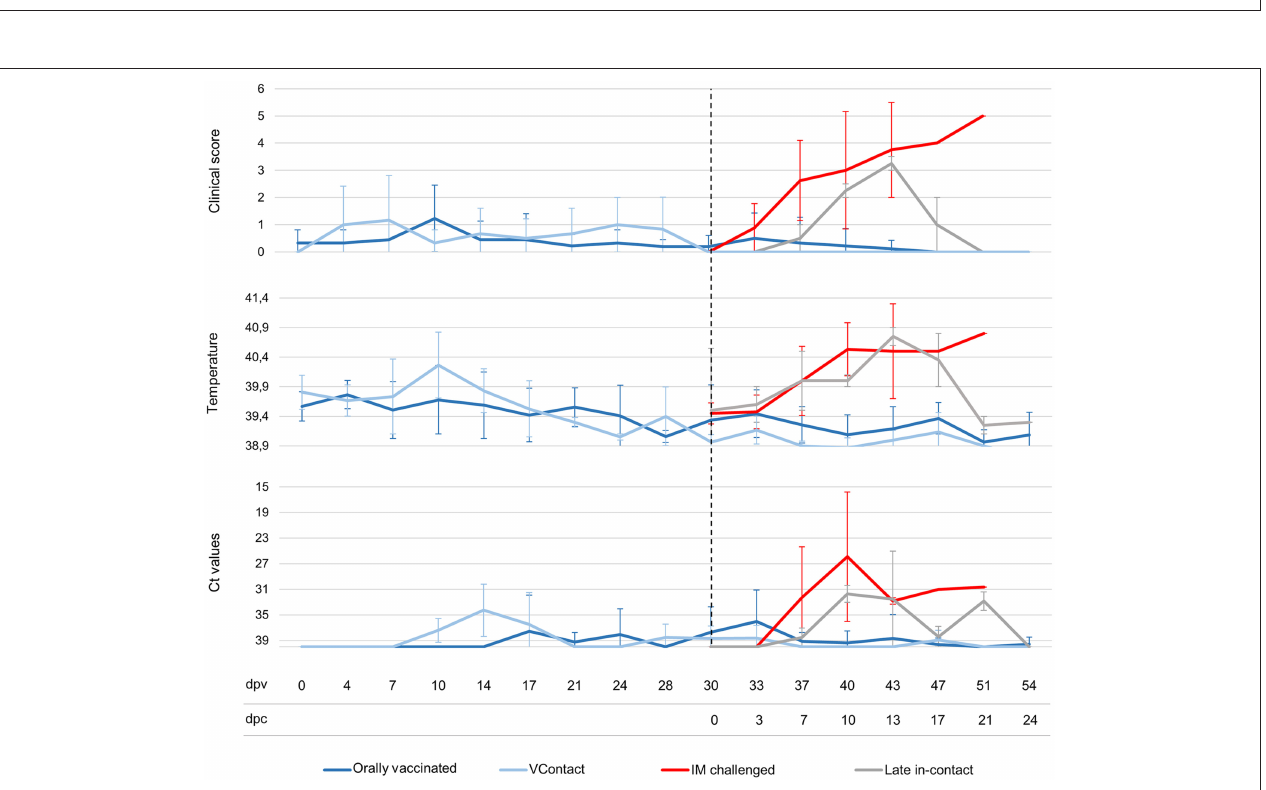
FIGURE 2 | Average of clinical scores, body temperatures and Ct values from real-time PCR of wild boar orally vaccinated with Lv17/WB/Rie1 ( n = 9; dark blue), exposed through contact (VContact, n = 3; light blue), intramuscularly challenged controls inoculated with virulent ASFV Arm07 ( n = 4; red) and late in-contact wild boar ( n = 2; gray). Averages are shown at different days post-vaccination (dpv), including days post-challenge (dpc). Error bars indicate SD.